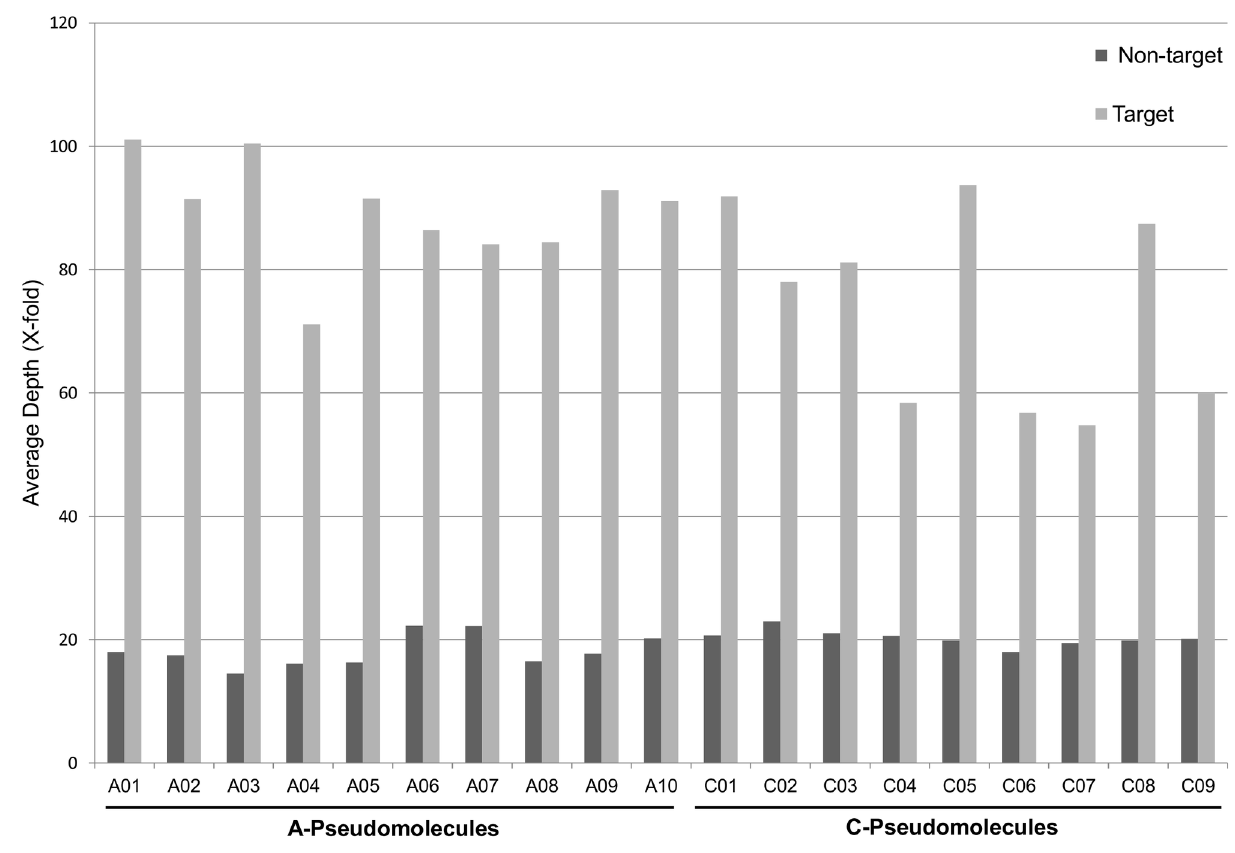
Figure 4. Summary of DNA sequence coverage. The average depth of coverage in captured and non-captured regions across all 19 A and C Brassica pseudomolecules is illustrated. Captured regions are those from the original sequence capture selection combined with the orthologous sequence from the complementary